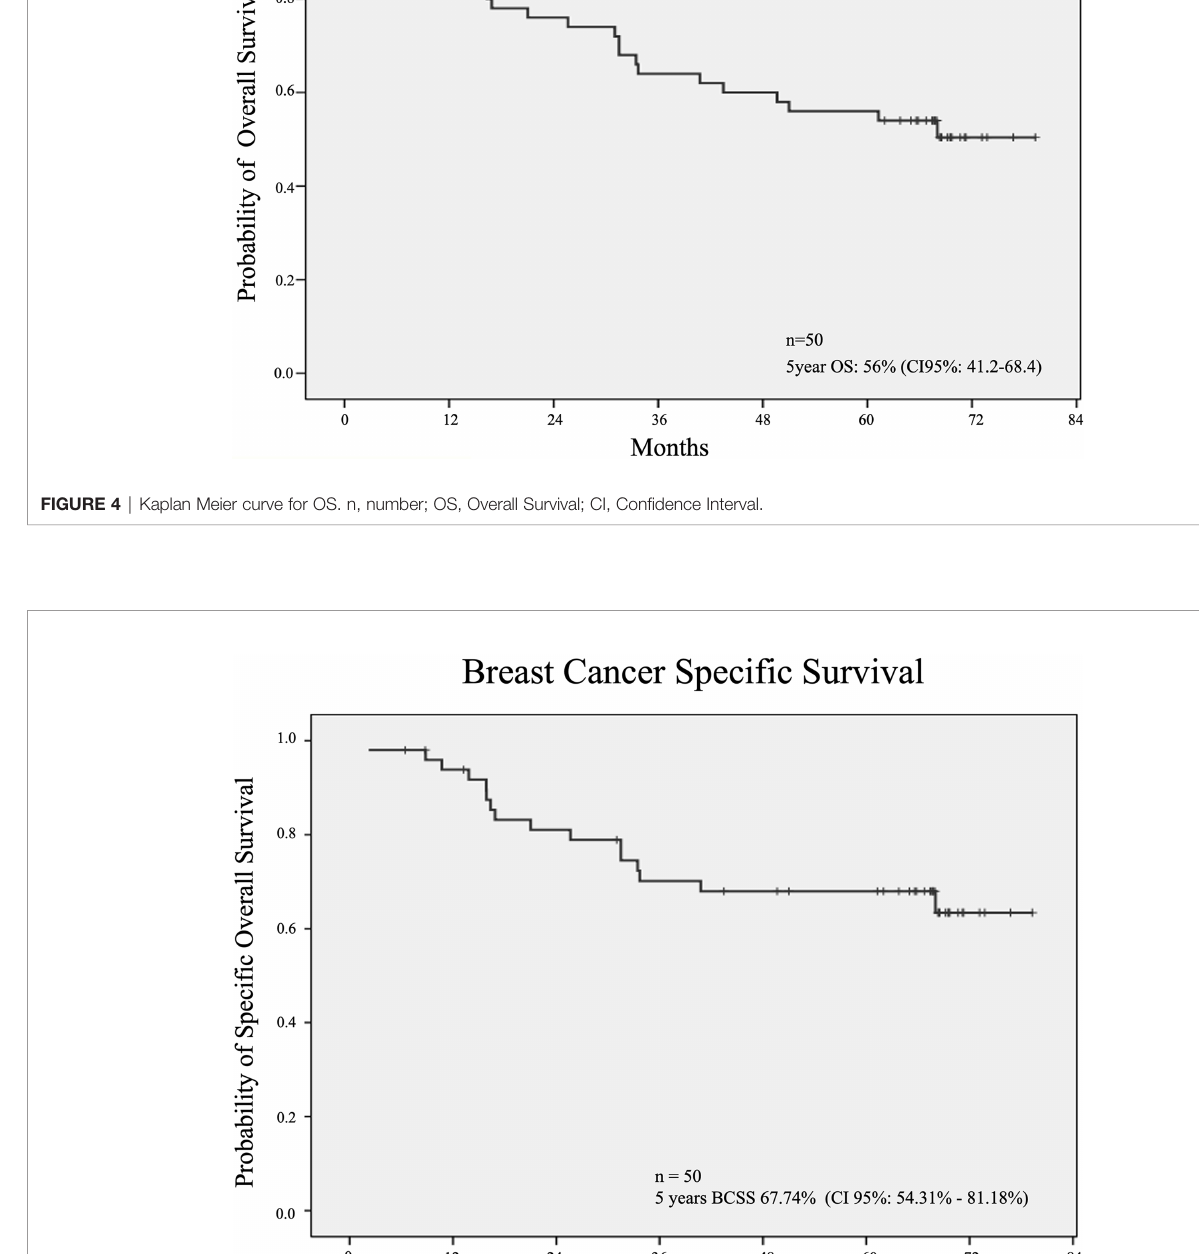
Frontiers in Oncology |